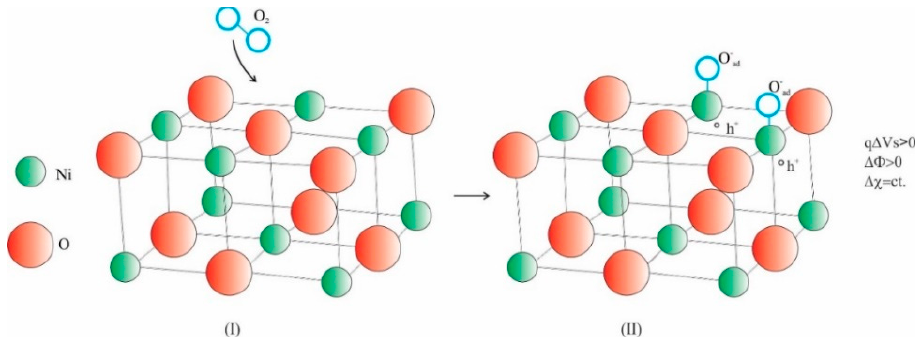
Figure 11. Cartoon revealing the interaction between atmospheric oxygen and NiO-sensitive